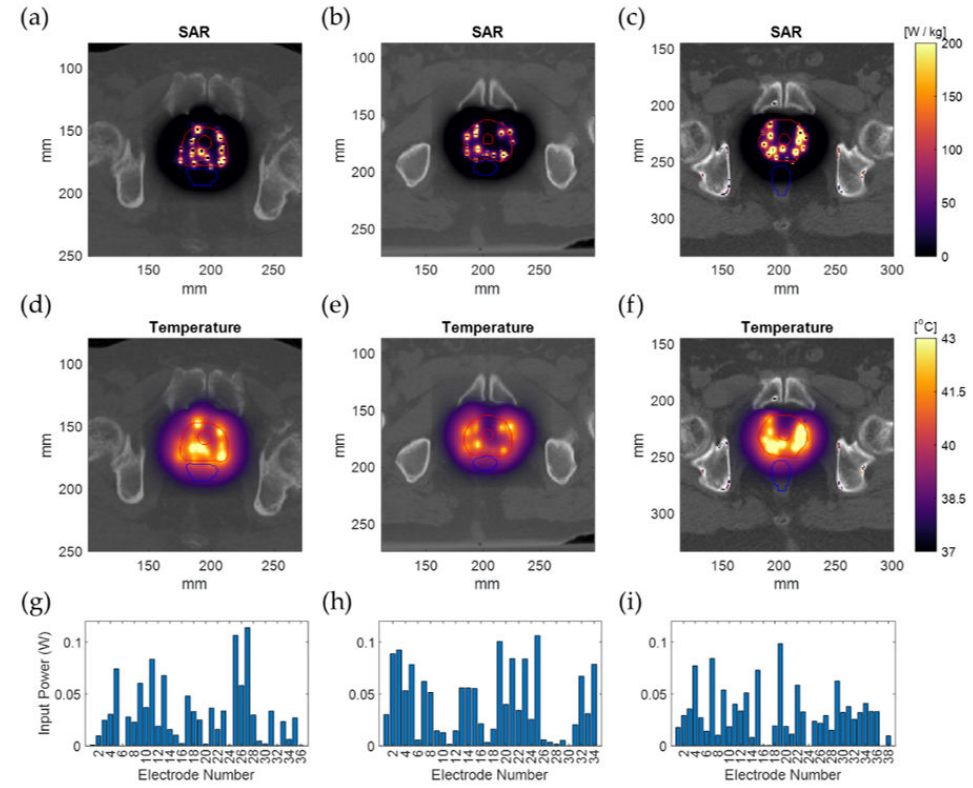
Figure 8. Simulation results for the real patient examples overlaid on the patient CT image. The SAR distribution ( a – c ); The temperature distribution after 20 min of heating ( d – f ); The input power applied on each implanted electrode ( g – i ). The outer and inner red lines represent the prostate and urethra contour, and the blue lines represent the rectum